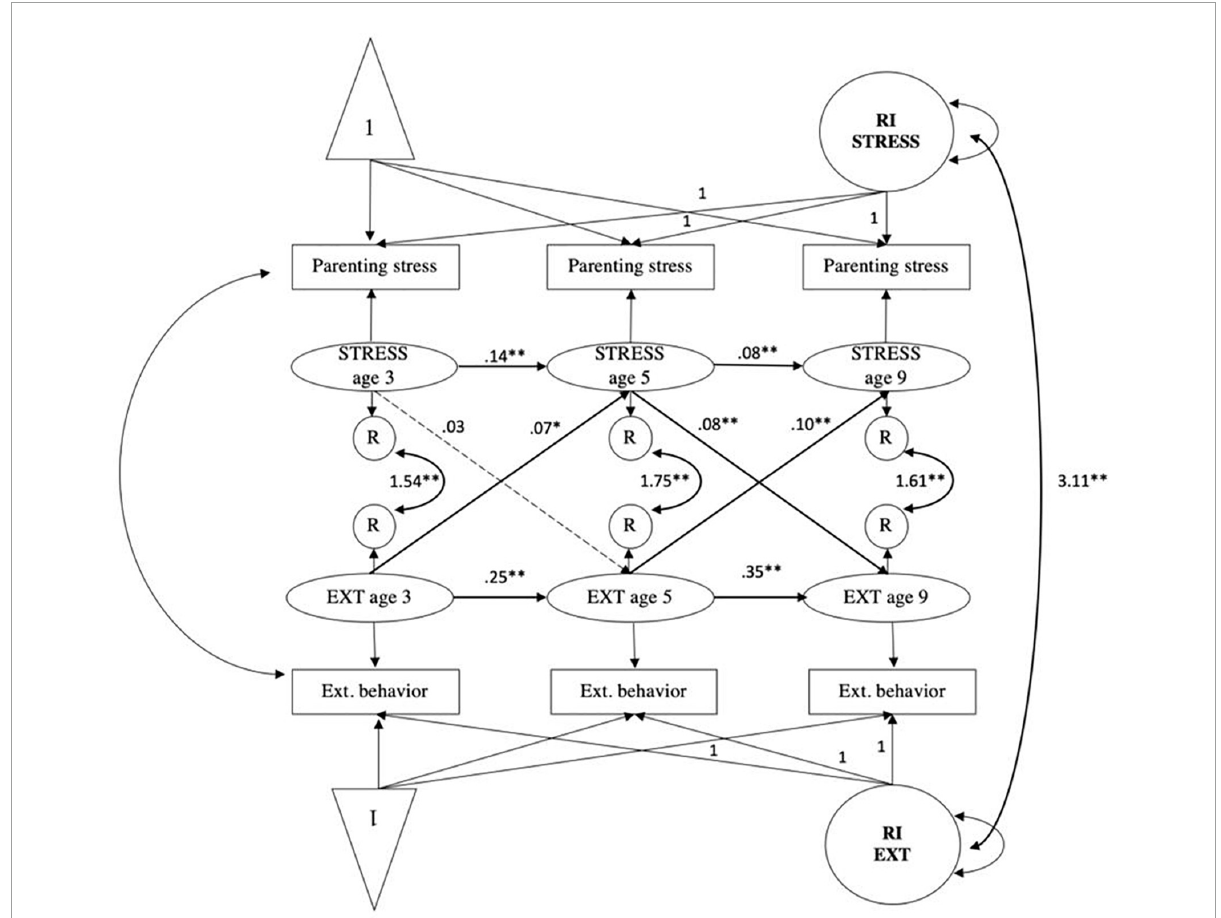
FIGURE4 Random intercepts cross-lagged panel model showing relations among parenting stress (STRESS) and child externalizing behaviors (EXT) across three waves. Age 3, wave 2; age 5, wave 3; age 9, wave 5; R, residual variance; RI EXT, random intercept child externalizing behavior; RI STRESS, random intercept parenting stress. Standardized estimates reported. Gray dashed paths indicated non-significant estimates. ∗ p < 0.01, ∗∗ p <